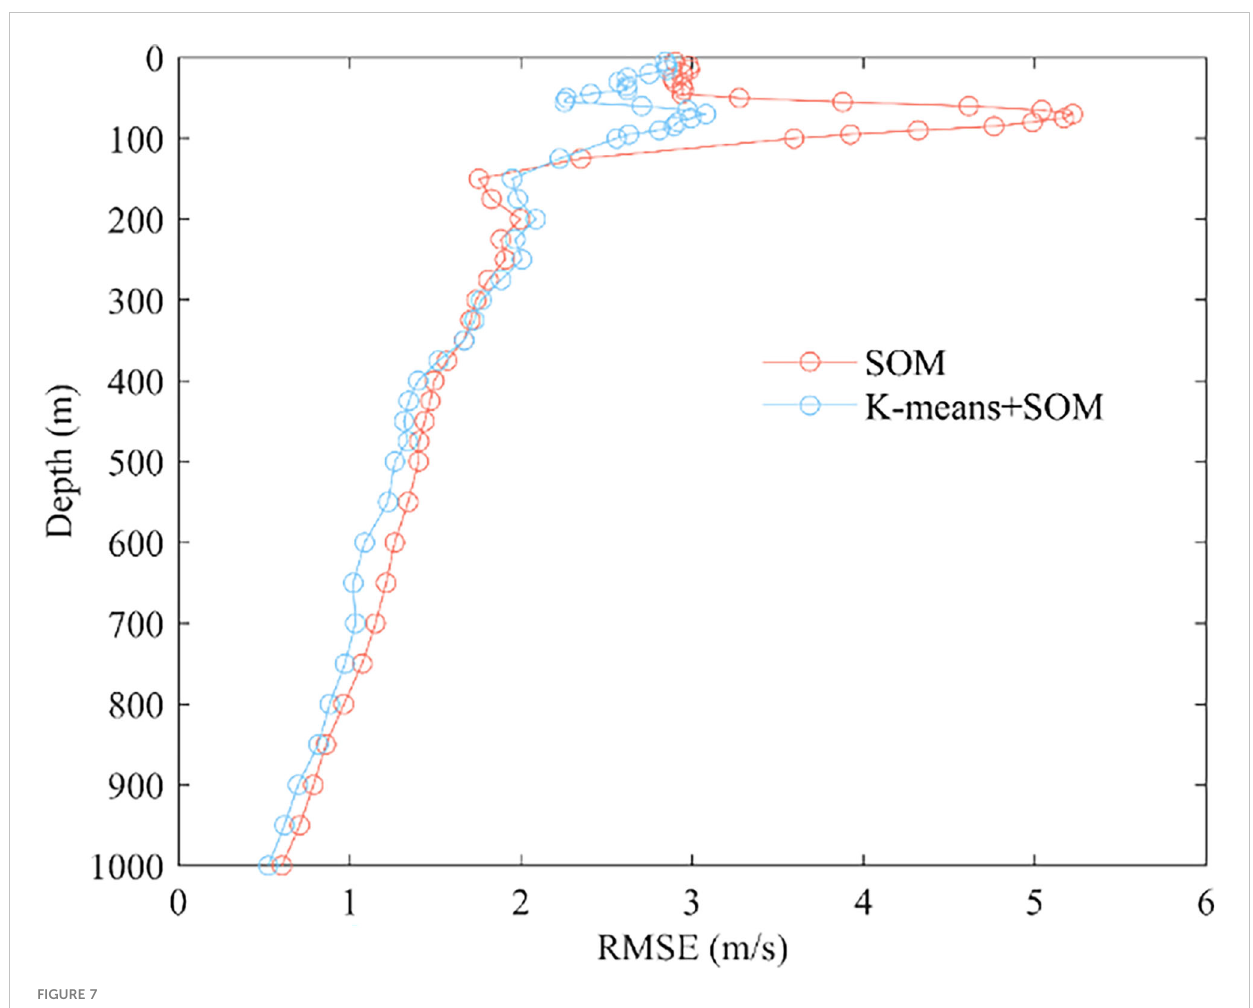
FIGURE 7 Error per depth of the test set.